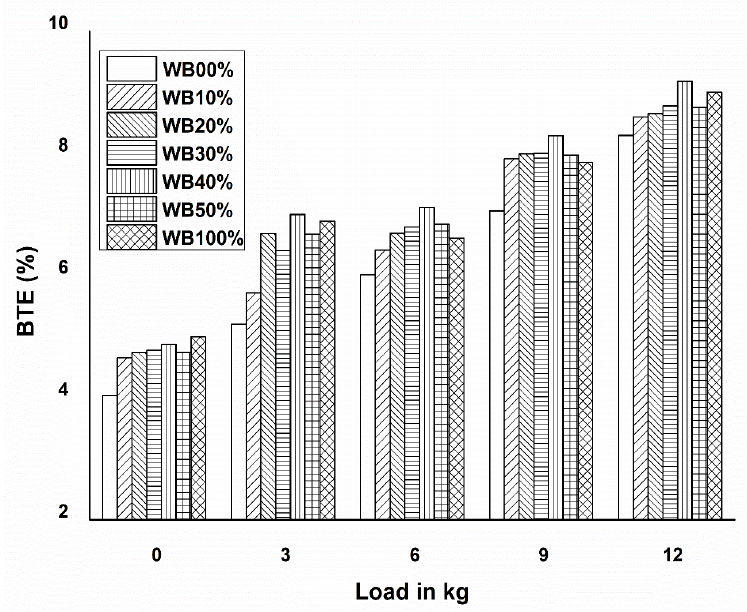
Figure 4. BTE variation against load in kg (WB00%—diesel fuel; WB10%—biodiesel 10% + diesel 90%; WB20%—biodiesel 20% + diesel 80%; WB30%—biodiesel 30% + diesel 70%; WB40%—biodiesel 40% + diesel 60%; WB50%—biodiesel 50% + diesel 50%; WB100%—pure biodiesel).